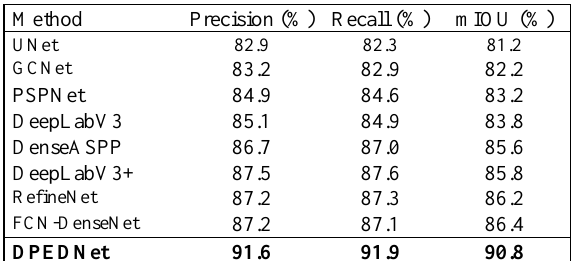
Table 2. Evaluation results on Crowded mapping challenge validation set.